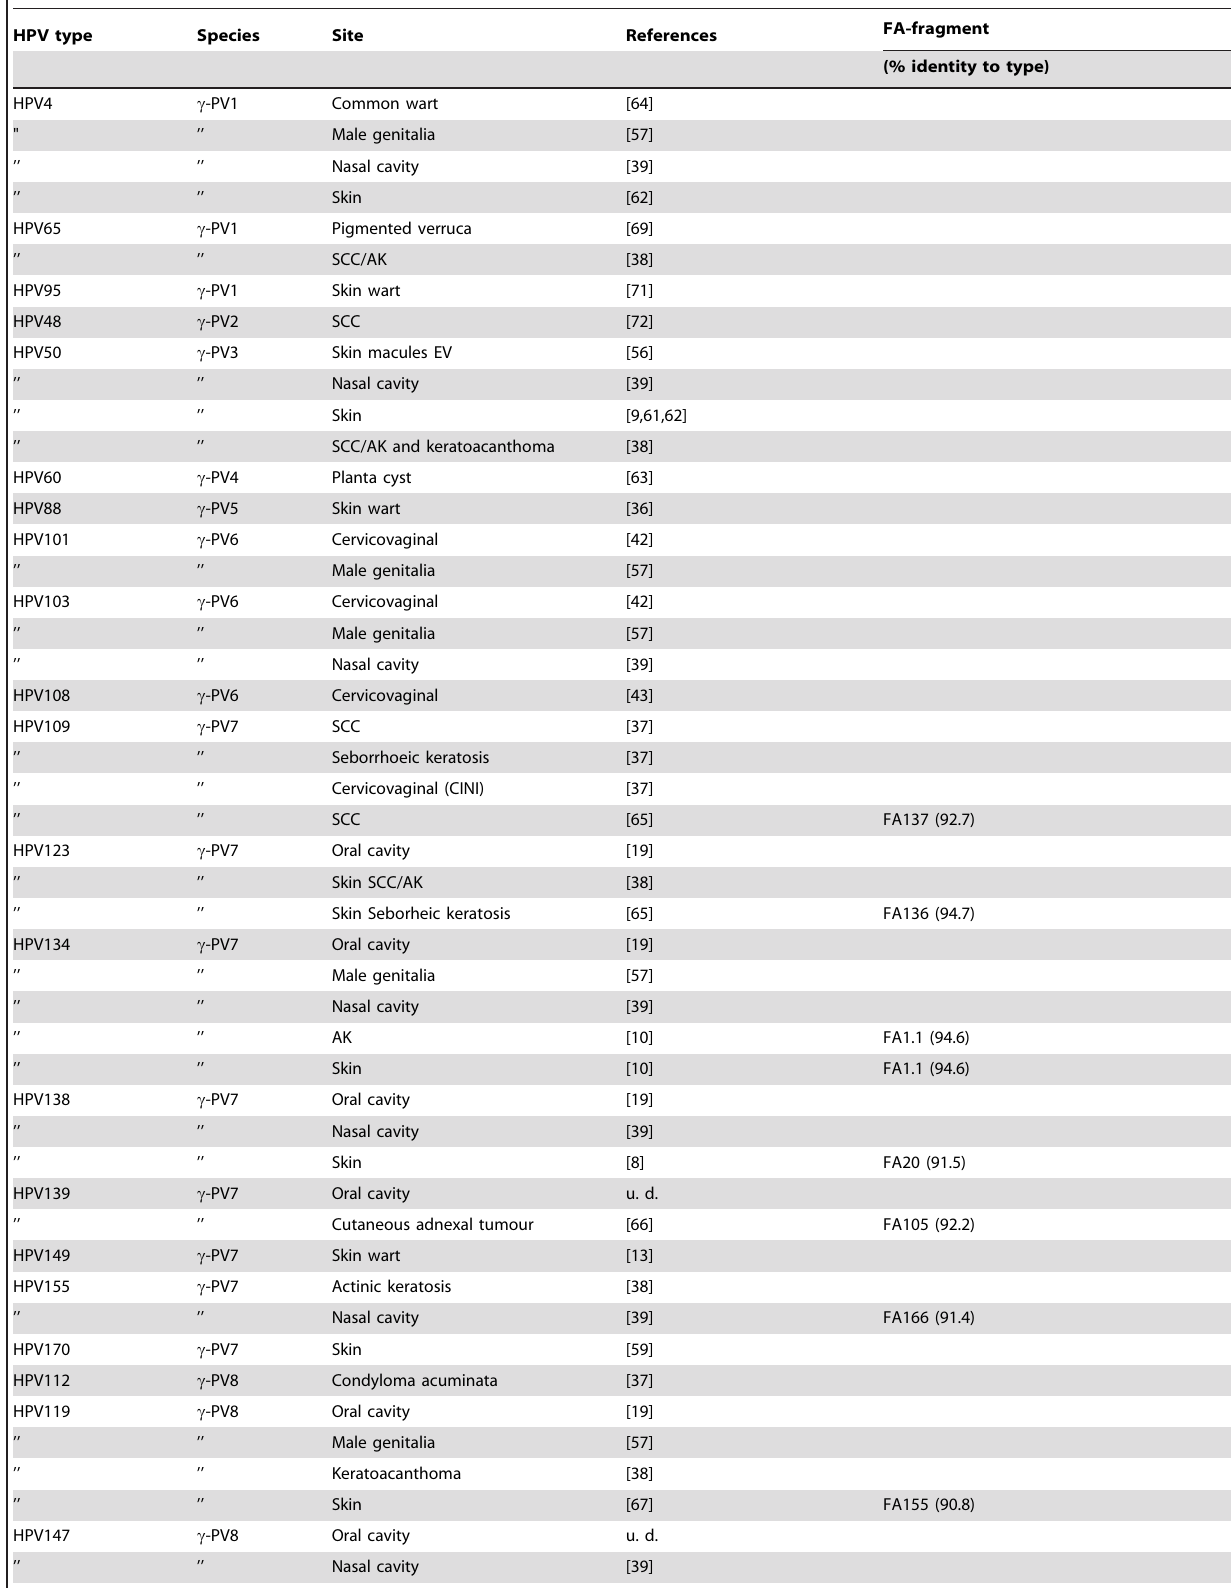
Table 2. Sites of detection of